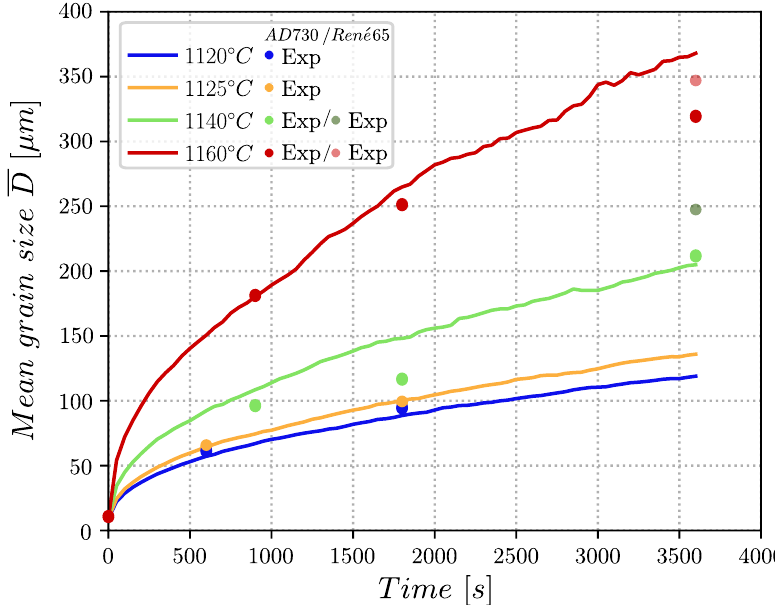
Figure 11. GG experimental data and simulations for different supersolvus heat treatments, to calibrate and validate the GB migration parameters M 0 and Q m values for the AD 730/ René 65